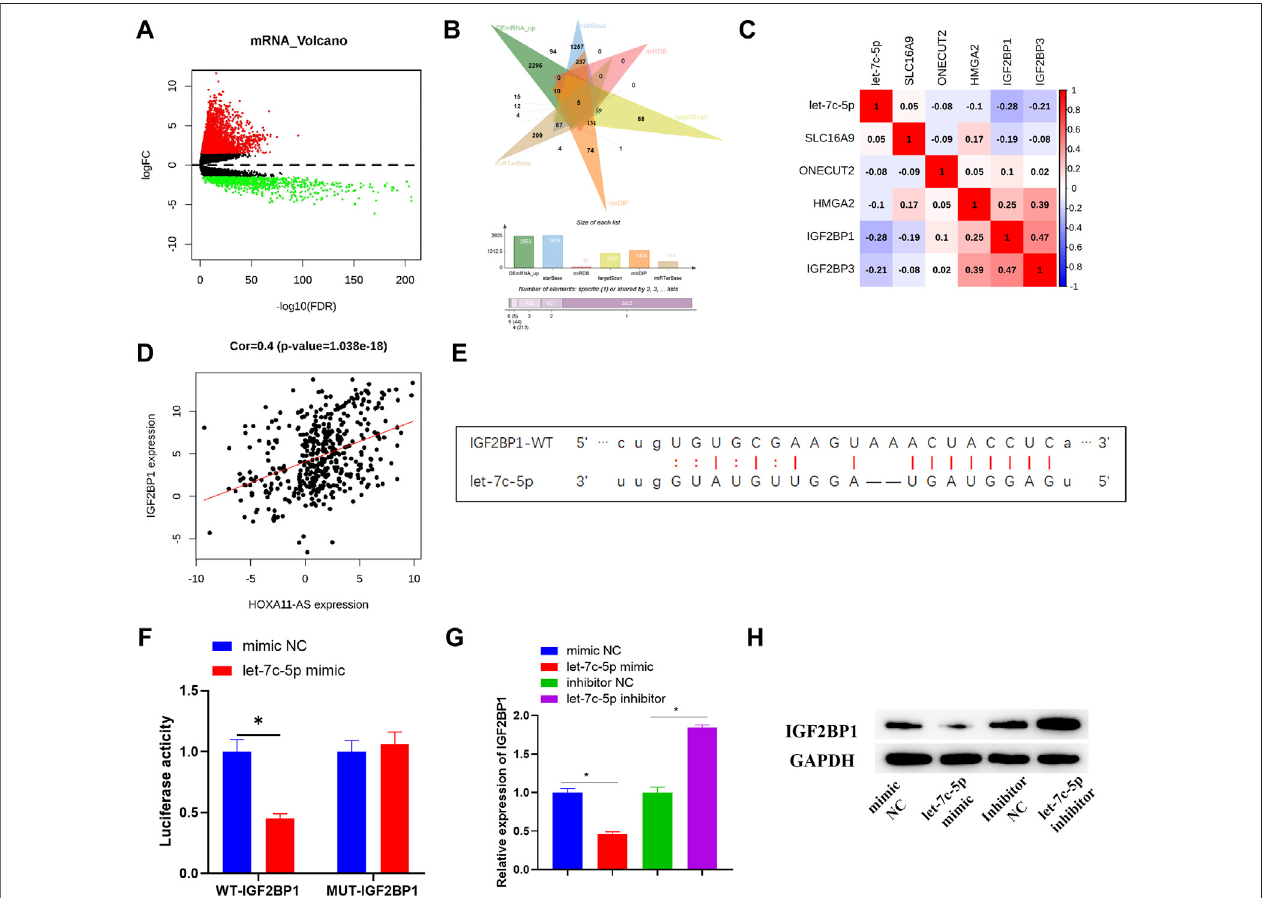
FIGURE4| IGF2BP1istargetedandregulatedbylet-7c-5p. (A) DifferentiallyexpressedmRNAsinnormalgroupandtumorgroupwasanalyzedandtheresultwas displayedin the Volcano Plot,in which red representsupregulated mRNAs and green representsdownregulatedmRNAs. (B) Venn diagram depicted theintersection of predicted target mRNAsanddifferentiallyupregulatedmRNAs. (C,D) Pearsoncorrelationanalysison potentialtargetmRNAsand let-7c-5p, and thecorrelationanalysis betweenIGF2BP1andHOXA11-AS. (E) Thetargetbindingsequenceoflet-7c-5ponIGF2BP13 ′ UTRwaspredicted onstarBasedatabase. (F) Thetargetbinding relationship of let-7c-5p and IGF2BP1 identi fi ed by dual-luciferase reporter detection. (G) qRT-PCR assessed expression level of IGF2BP1 mRNA after transfection in each group. (H) The expression of IGF2BP1 protein in each group of cells was tested in Western blot assay; * p <